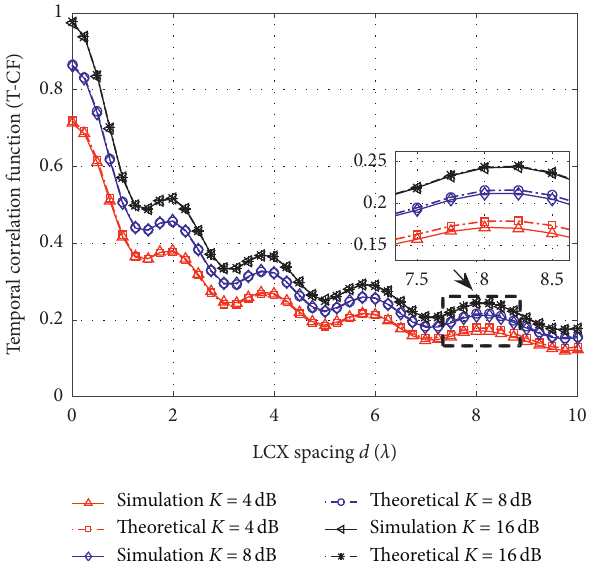
Figure 5: T-CF of LCX-MIMO for various LCX spacing with different K- factors ( K � 360km/h), and l � 0.5 v RX